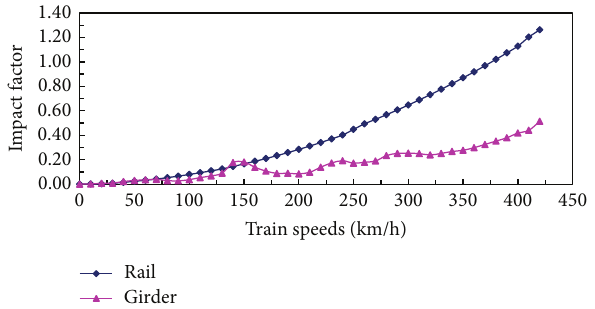
Figure 29: Maximum vertical impact factor of bridge midpoint under various train speeds (rail/girder).